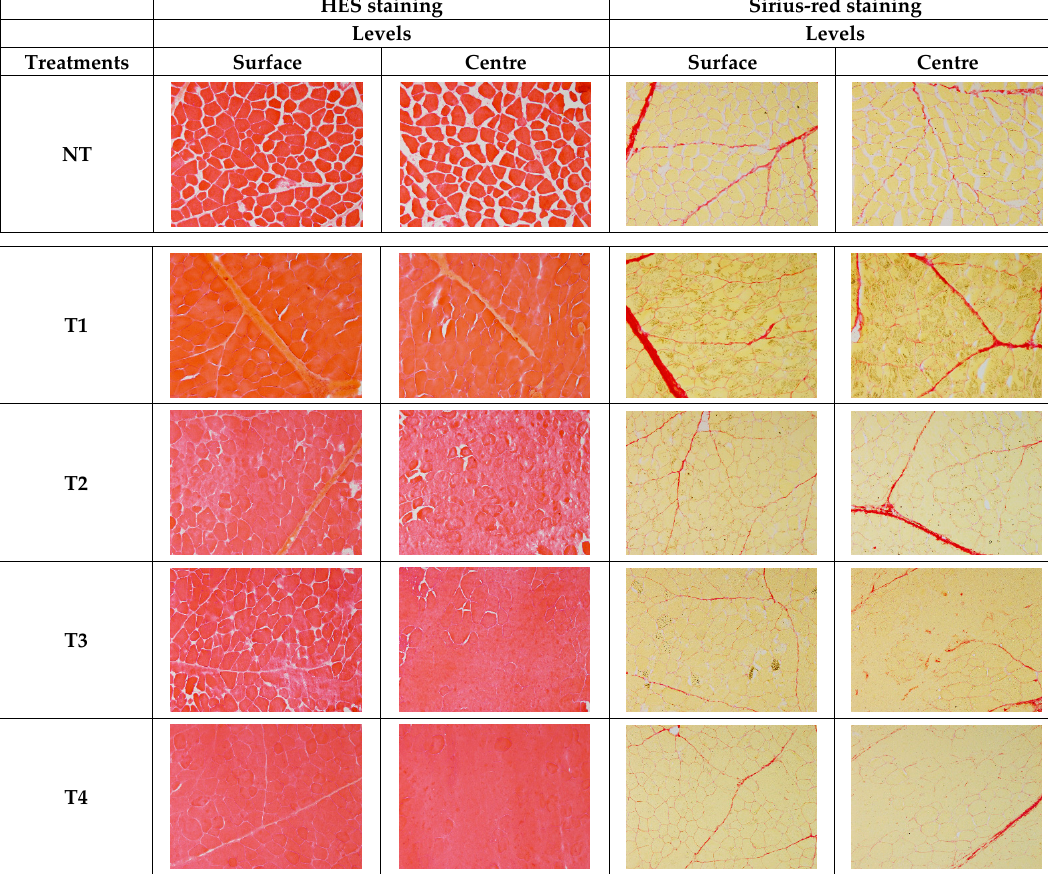
Figure 4. Haematoxylin ‐ eosin ‐ safron and picro ‐ sirius red staining of muscle tissue morphology at two locations, i.e., sur ‐ Figure 4. Haematoxylin-eosin-safron and picro-sirius red staining of muscle tissue morphology at two locations, i.e., surface face and centre, of raw beef Semintendinosus meat pieces having undergone five different mechanical treatments: NT (con ‐ and centre, of raw beef Semintendinosus meat pieces having undergone five different mechanical treatments: NT (control, no trol, no mechanical treatment), T1 (2500 compression cycles, about 3 h), T2 (6000 compression cycles, about 7.5 h), T3 (9500 compression cycles, about 12 h) and T4 (13,000 compression cycles, about 16 h). Muscle fibres are coloured in red and mechanical treatment), T1 (2500 compression cycles, about 3 h), T2 (6000 compression cycles, about 7.5 h), T3 (9500 compres- extracellular spaces are coloured in white for HES staining. Muscle fibres are coloured in yellow and connective tissue is sion cycles, about 12 h) and T4 (13,000 compression cycles, about 16 h). Muscle fibres are coloured in red and extracellular coloured in red for RS staining. spaces are coloured in white for HES staining. Muscle fibres are coloured in yellow and connective tissue is coloured in red HES staining showed that longer tumbling times progressively decreased the extra ‐ for RS (Figure 4). Moreover, compared to NT samples, longer tumbling times caused microstruc ‐ tural changes that differed depending on location in the piece of meat. Structural degra ‐ dation was more intense and size of the extracellular spaces was even smaller in the centre (C) than at the surface (S) of the tumbled meat pieces. Increasing the tumbling time (T1 to T4) promoted a gradual reduction in the extra ‐ cellular space areas and thus a reduction in the distance between muscles fibres. However, from treatment T2 (6000 compression cycles, about 7.5 h of mechanical treatment), areas started to appear in which it was nearly impossible to distinguish the muscle fibres indi ‐ vidually (amorphous zones), probably as a result of the compaction of the muscle fibres. Images from experiments NT, T2, T3 and T4 were used to obtain data for character ‐ izing the changes in muscle fibres, amorphous cross ‐ sectional areas (Figure 5A) and ex ‐ tracellular space areas (Figure 5B) according to the sampling depth, i.e., at the meat surface or in the centre. Amorphous ‐ zone areas increased with increasing tumbling time, depend ‐ ing on the depth level investigated: amorphous zone area increased exponentially in the centre of the tumbled meat pieces but only moderately in the surface (Figure 5A). Figure 5B shows that the extracellular space areas were reduced by half in treatment T2 in both surface and centre samples, whereas treatments T3 and T4 led to smaller extracel ‐ lular spaces in centre samples than surface samples.